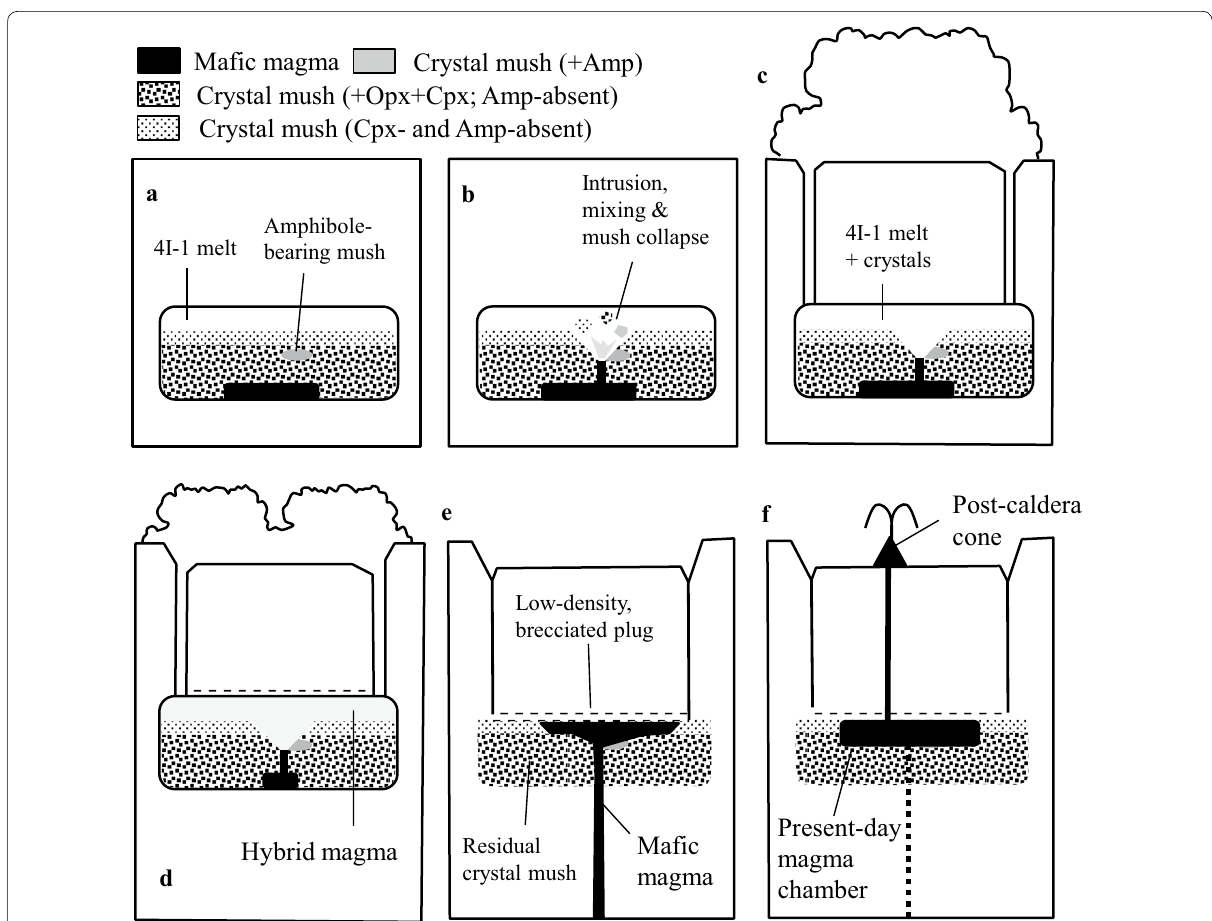
Fig. 5 Schematic diagrams showing a the state before the Aso-4 event started. Amphibole- and Cpx-free crystal mush underlying the 4I-1 melt chamber and overlying two-pyroxene-bearing crystal mush with a local amphibole-bearing part; b the mafic magma started intrusion into the 4I-1 melt chamber. The initially intruded mafic magma was mixed with the 4I-1 melt to form small volume of hybrid magma, which crystallized Al-enriched amphiboles. In addition, the intrusion induced partial collapse of the crystal mush; c the hybrid magma and crystals derived from the collapsed mush were incorporated into and mixed with the 4I-1 melt, and the magma erupted to form the 4I-1 pyroclastic flow; d large volume of the mafic magma intruded into and mixed with the residual 4I-1 melt to form abundant hybrid magma, which erupted in the later stage of Aso-4 eruption; e after Aso eruption ended, low-density breccias and residual crystal mush acted as density barrier for ascending mafic magma, resulting in formation of mafic magma reservoir at the depth similar to the Aso-4 magma reservoir; f in post-caldera stage, mafic magmas derived from